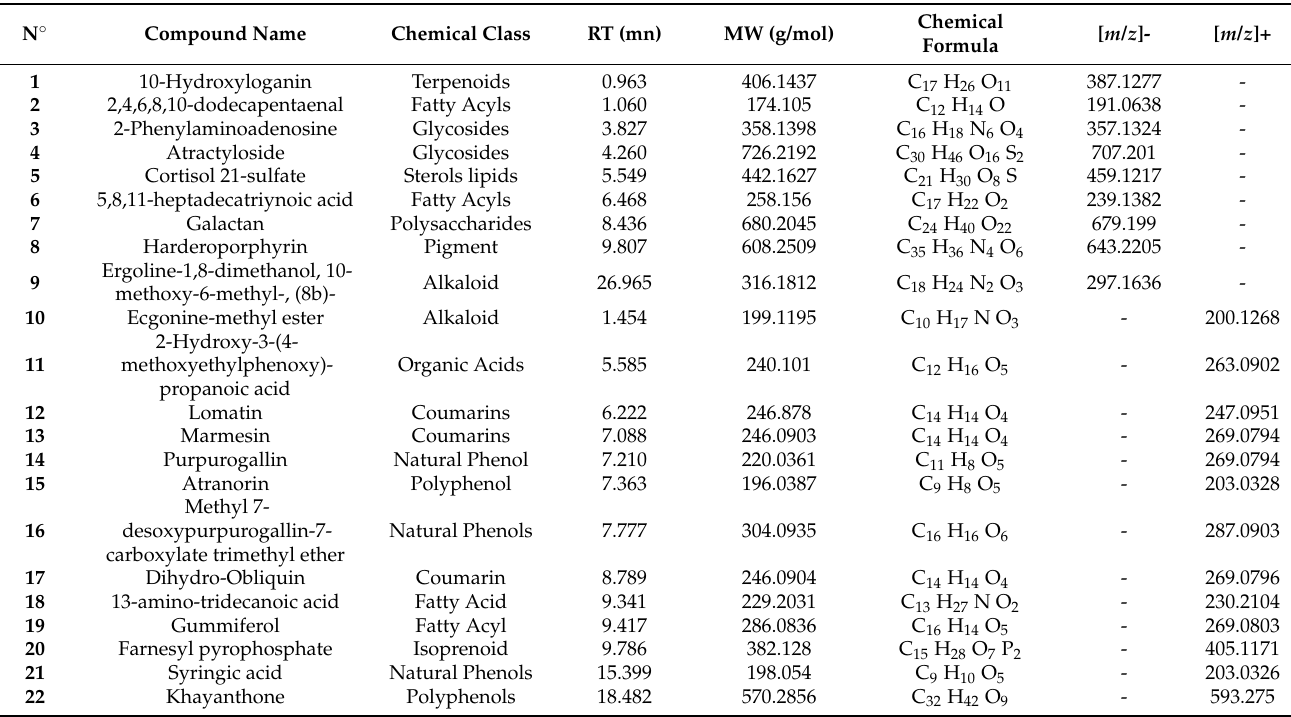
Table 2. Phytochemical compounds identified by the HR-LCMS technique in D. flabellifolia methano- lic